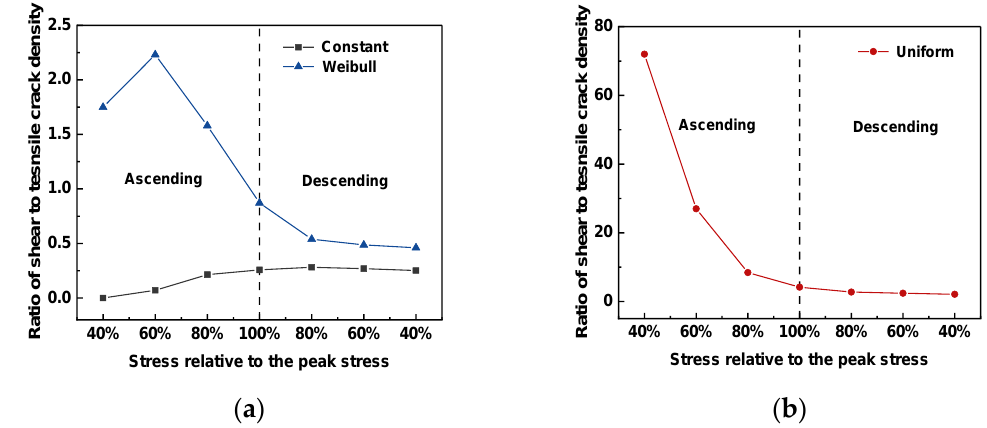
Figure 12. Ratio of crack density of different cases with respect to the stress relative to the peak stress. ( a ) Constant and Weibull distributions; ( b ) uniform distribution.